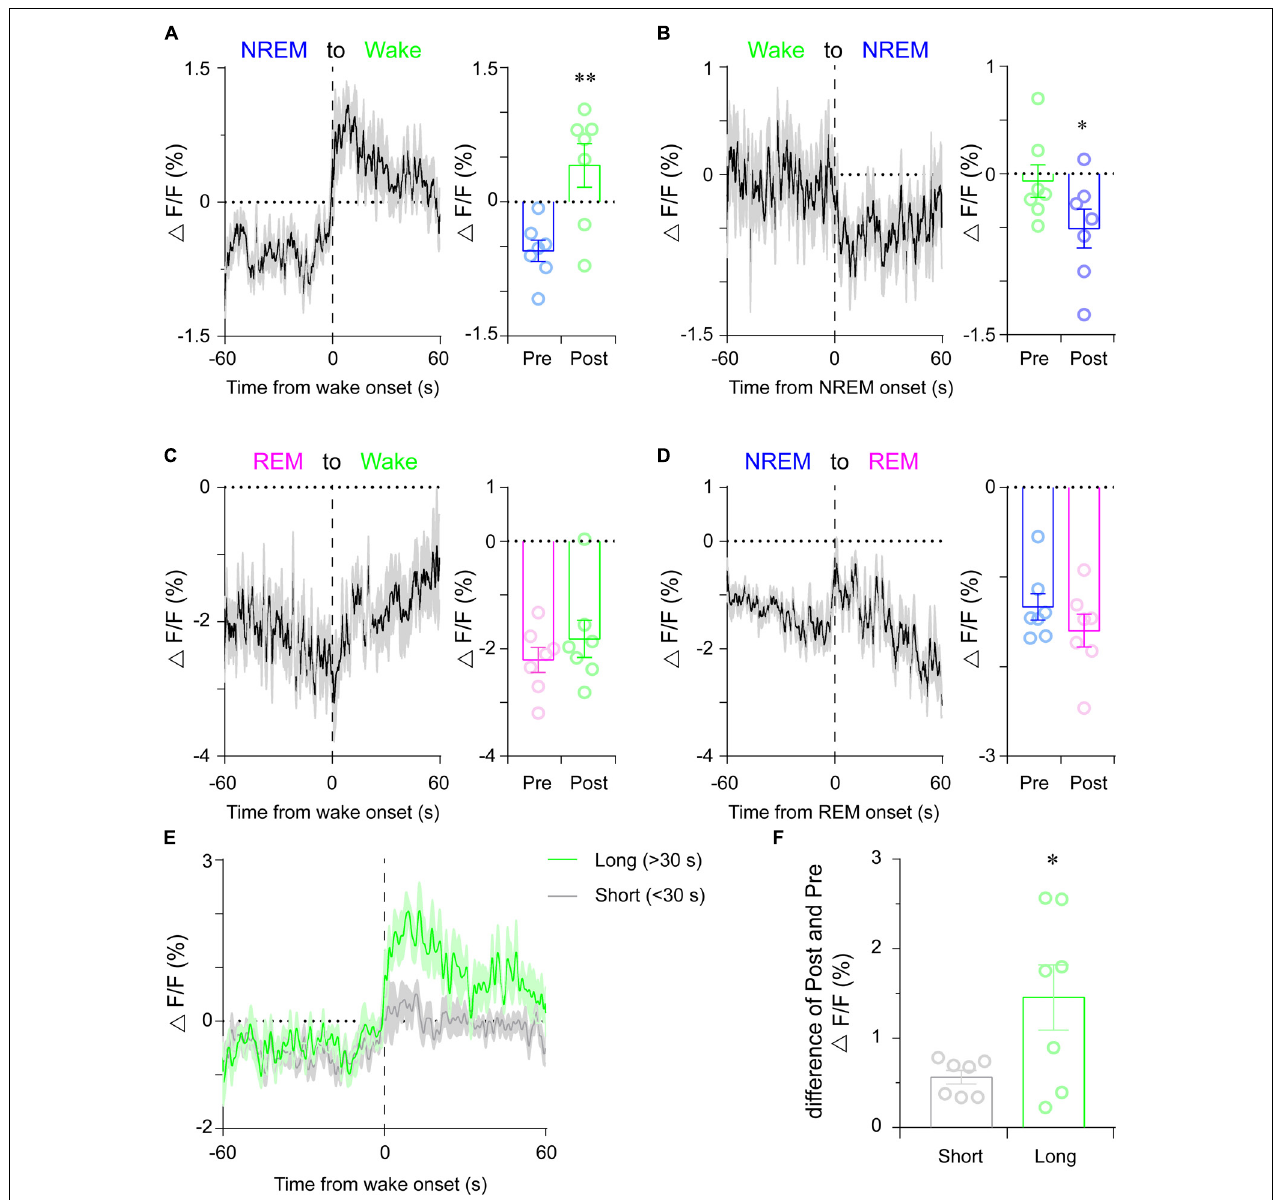
FIGURE 2 | Striatal dLight1.1 signal dynamics across spontaneous sleep-state transitions. (A) Striatal dLight1.1 signals across NREM sleep-to-wake transition. (Left) The time course of the dLight1.1 signal across the NREM sleep-to-wake transition. (Right) The average amplitude of the dLight1.1 signal 60 s pre- and post-transition ( t 6 = 5.441, ∗∗ P < 0.01, n = 7 mice). (B) Striatal dLight1.1 signal at the wake-to-NREM sleep transition. (Left) The time course of the dLight1.1 signal across the wake-to-NREM sleep transition. (Right) The average amplitude of the dLight1.1 signal 60 s pre- and post-transition ( t 6 = 2.528, ∗ P = 0.044). (C) Striatal dLight1.1 signal at the REM sleep-to-wake transition. (Left) The time course of the dLight1.1 signal across the REM sleep-to-wake transition. (Right) The average amplitude of the dLight1.1 signal 60 s pre- and post-transition the ( t 6 = 1.053, P = 0.333). (D) Striatal dLight1.1 signal at the NREM-to-REM sleep transition.